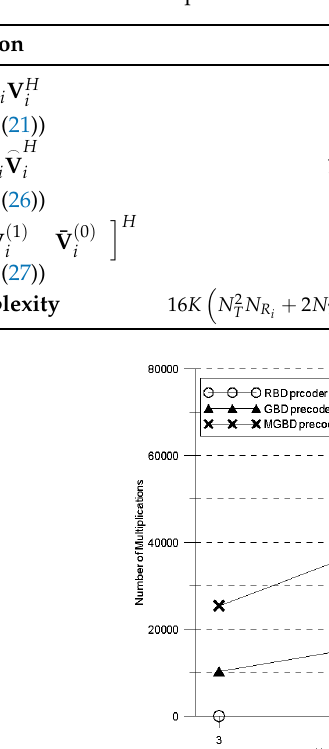
Table 5. Computational complexity for MGBD precoder.